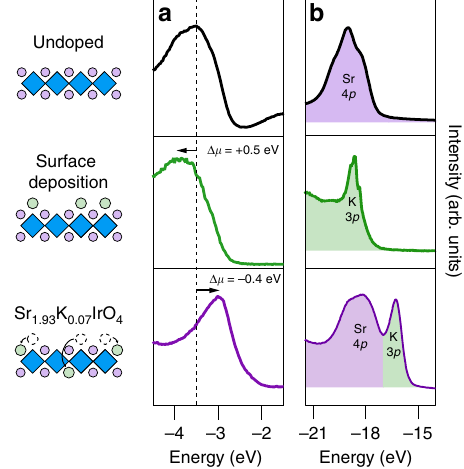
Fig. 1 Photoemission measurements showing change in chemical potential and core level spectra upon doping Sr 2 IrO 4 . a Measurement of the chemical potential shift, Δ μ , for a pristine undoped sample (top), after K surface deposition (middle), and after substitutional diffusion (bottom) with h ν = 21.2 eV at k x , k y = (0,0). b Corresponding core level spectra measured with He II photons ( h ν = 40.8 eV). K peak locations are consistent with reference spectra for elemental 29 and oxidized K 30